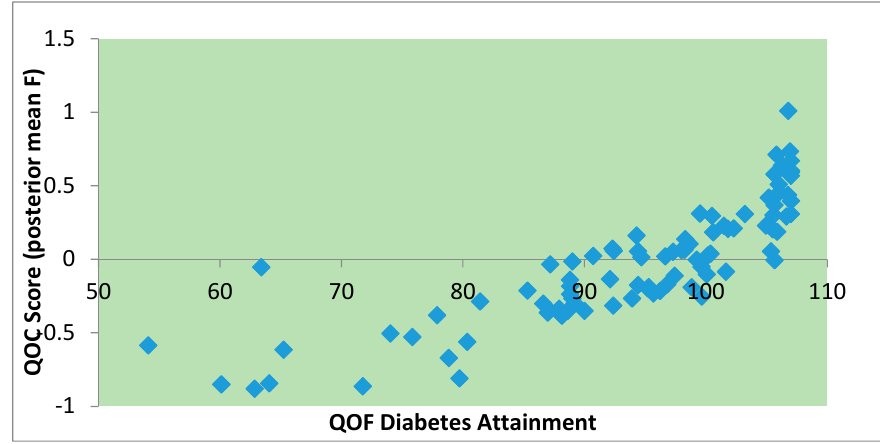
Figure 3. Modelled quality of care scores vs. QOF attainment scores.